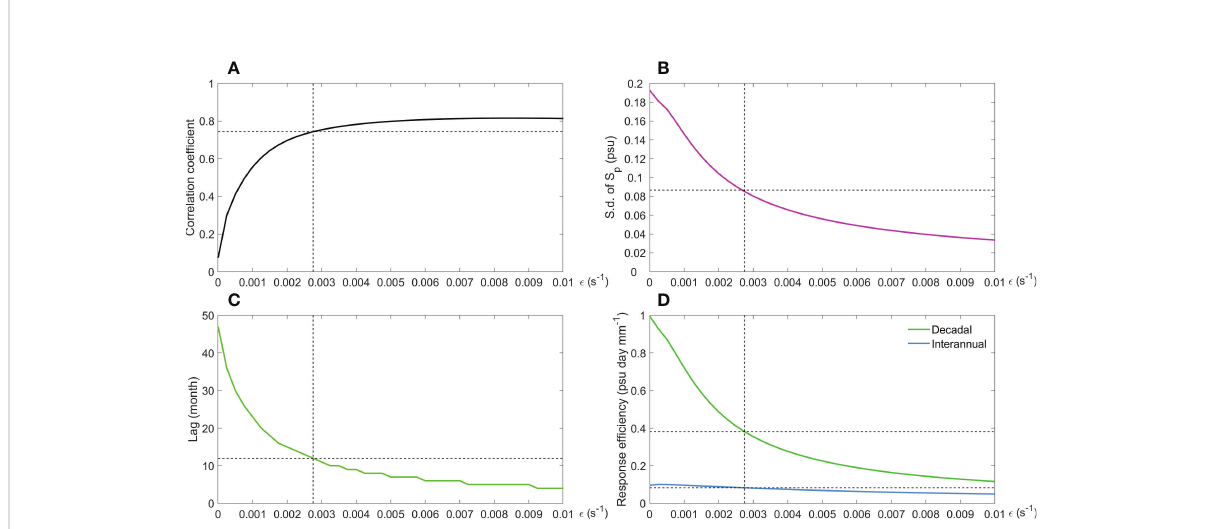
FIGURE 10 Results of LRSM simulations as functions of e varying from 0 to 0.01 s -1 . (A) The correlation coef fi cient between the SSSA from Exp-BP minus Exp-B and those from by LRSM. (B) The standard deviation of S p . (C) The time lag (in month) of decadal (6-year low-passed S p ) to decadal precipitation as the function of e , obtained through a lead-lag correlation analysis. (D) The response ef fi ciency of salinity to precipitation (psu day mm -1 ), calculated as the ratio of standard deviation of S p to that of P . Blue and green lines show the results for interannual variability (6-year high-passed) and decadal variability, respectively. In all panels, e = 2.75 × 10 -3 s -1 and corresponding results are marked with dashed